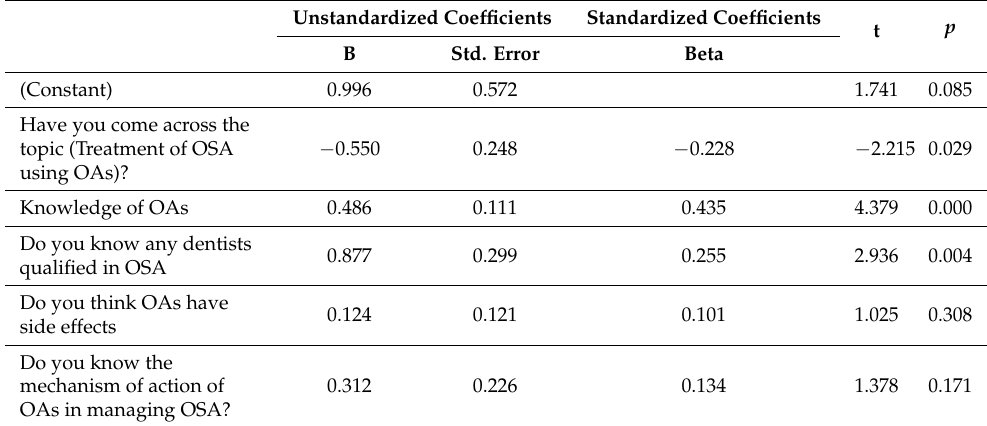
Table 3. Linear regression model showing the association between the frequency of referral (or not) for oral appliances and experiential factors.